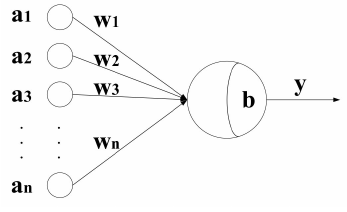
Figure 2. Fully connected layer structure.